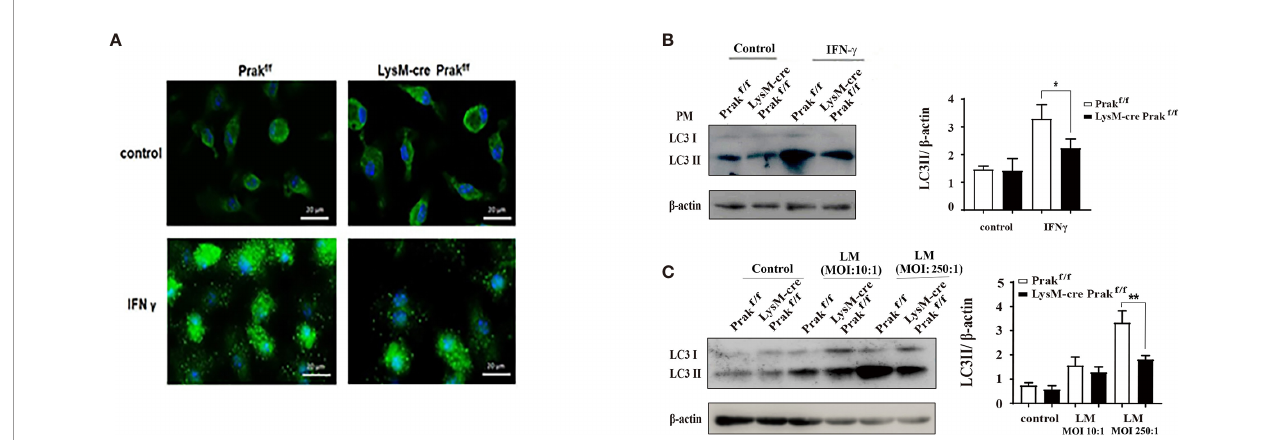
FIGURE 5 | Autophagy induction in Prak -de fi cient macrophages. (A) TG-elicited peritoneal macrophages from Prak- de fi cient and wild type mice were allowed to rest overnight and then treated with or without IFN- g for 24 hours. Confocal microscopy examination was performed after staining with anti-LC3 (green) and DAPI (blue). Images are representative of 3-4 independent experiments. Scale bars, 20 m m. (B) Cells were processed as in (A) Western blotting was performed to detect the generation of LC3II. b -actin served as a loading control. Representative blots from 3-4 independent experiments are shown on the left. The ratio of LC3II/ b -actin is shown as mean ± SD on the right. * P < 0.05 by t -test. (C) Peritoneal or bone marrow-derived macrophages were incubated with L. monocytogenes at a MOI of 10 or 250 for 24 h. LC3II levels were revealed by Western blotting. Representative blots from four independent experiments are shown on the left. The ratio of LC3II/ b -actin is shown as mean ± SD on the right. * P < 0.01 by t -test; ** P < 0.001 by t